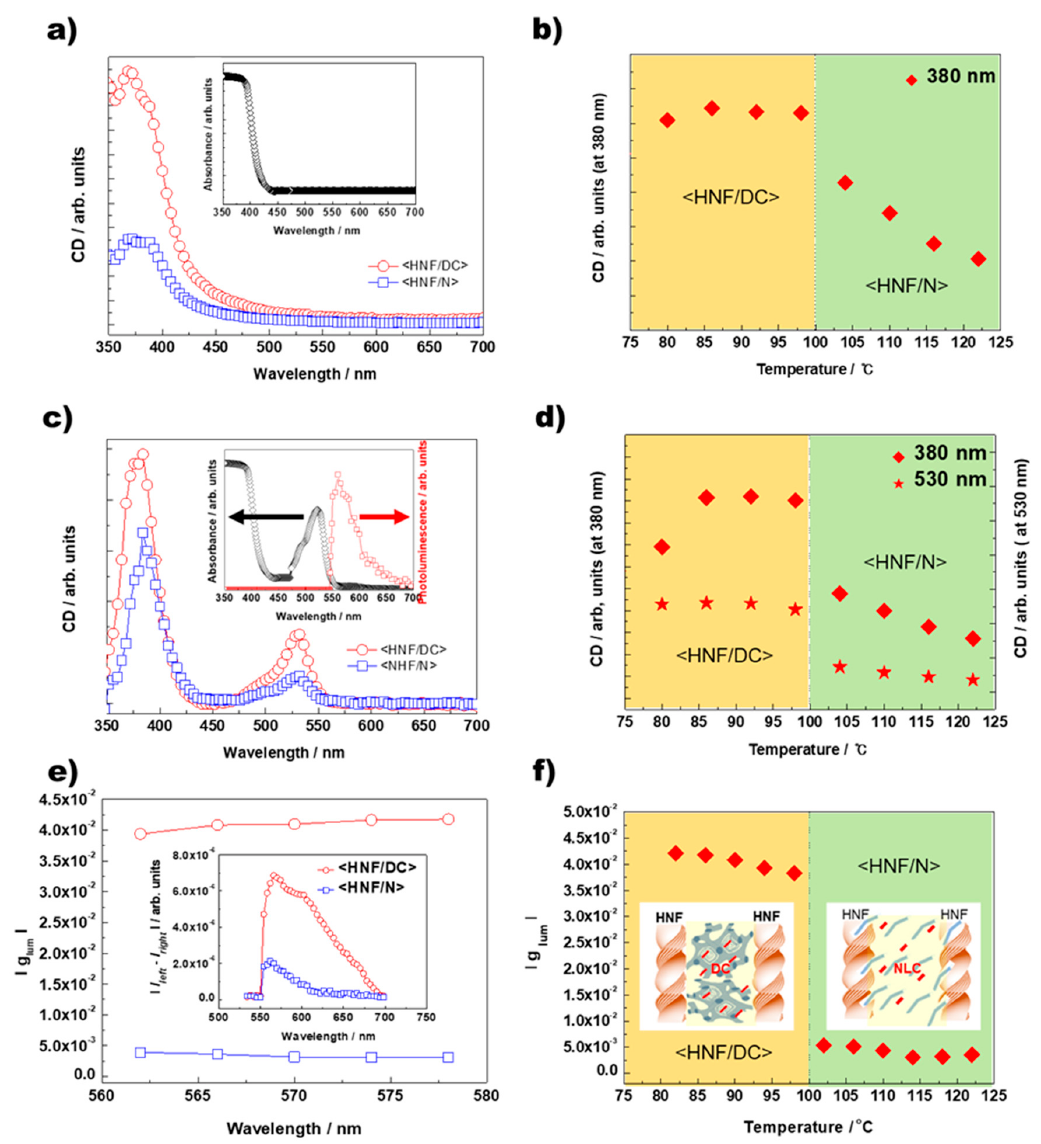
Figure 5. ( a ) Typical CD spectra generated for M1 <HNF/N> and <HNF/DC> positive chiral domains. The M1 absorbance spectrum is also presented in the inset. ( b ) Positive domain maximum CD peak intensity at ~380 nm plotted as a function of temperature. ( c ) Typical CD spectra generated for M2 <HNF/N> and <HNF/DC>. ( d ) Maximum CD peak intensities at ~530 and ~380 nm (originating from dye and BC-1/BC-2 absorbance bands, respectively) plotted as functions of the temperature. ( e ) |g lum | evaluated from CPL spectra generated at the <HNF/N> and <HNF/DC> emission bands. Typical <HNF/N> and <HNF/DC> | I left − I right | spectra are also shown in the inset. ( f ) |g lum | plotted as a function of the temperature. Plausible molecular organizations are also shown for dye molecules (indicated by red bars) embedded in a mixture consisting of two BC molecules at two nanosegregated phases.